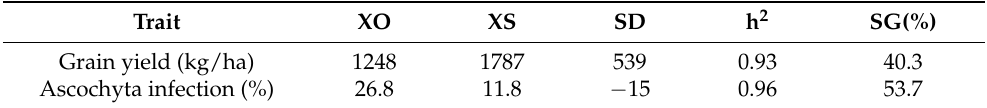
Table 6. Estimates of genetic parameters for GY and Ascochyta infection based on MTSI for the 14 chickpea accessions tested in 10 environments.